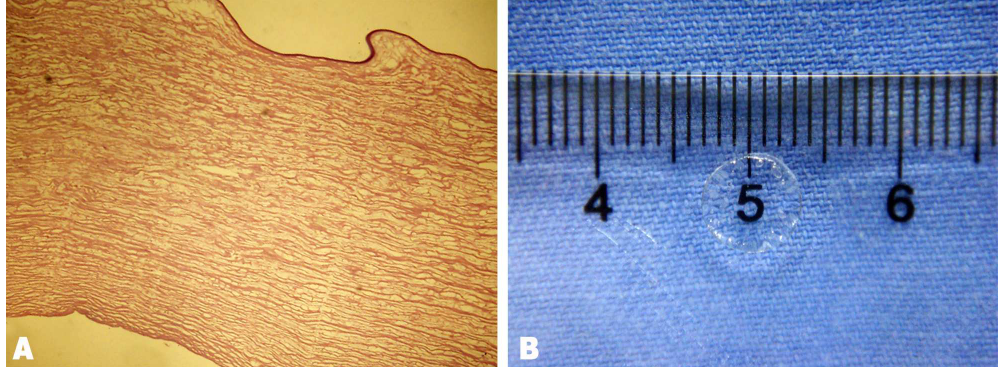
Fig 2. Representative image and histological characteristics of the APCM. H&E (A) staining showedthat the cells were completelyremoved. The scaffold was transparentwhen soaked in 100% sterile